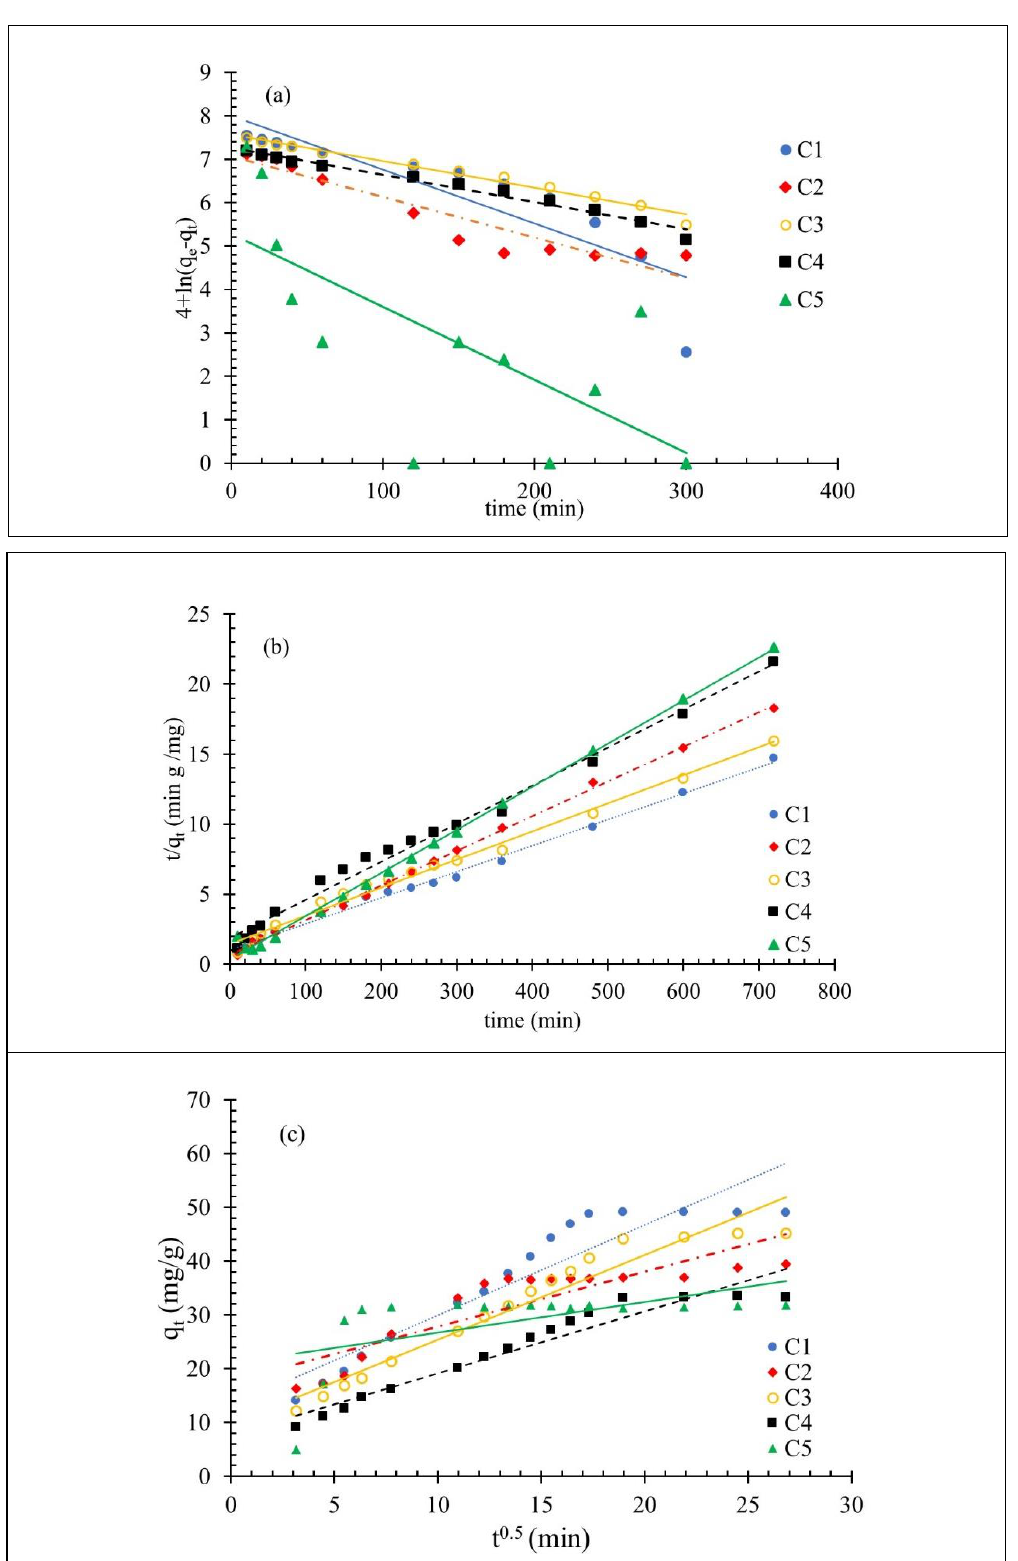
Figure 12. Statistical fitting of data from adsorption of lead onto different clays using different kinetic models: ( a ) pseudo first order, ( b ) pseudo second order, ( c ) intraparticle diffusion.